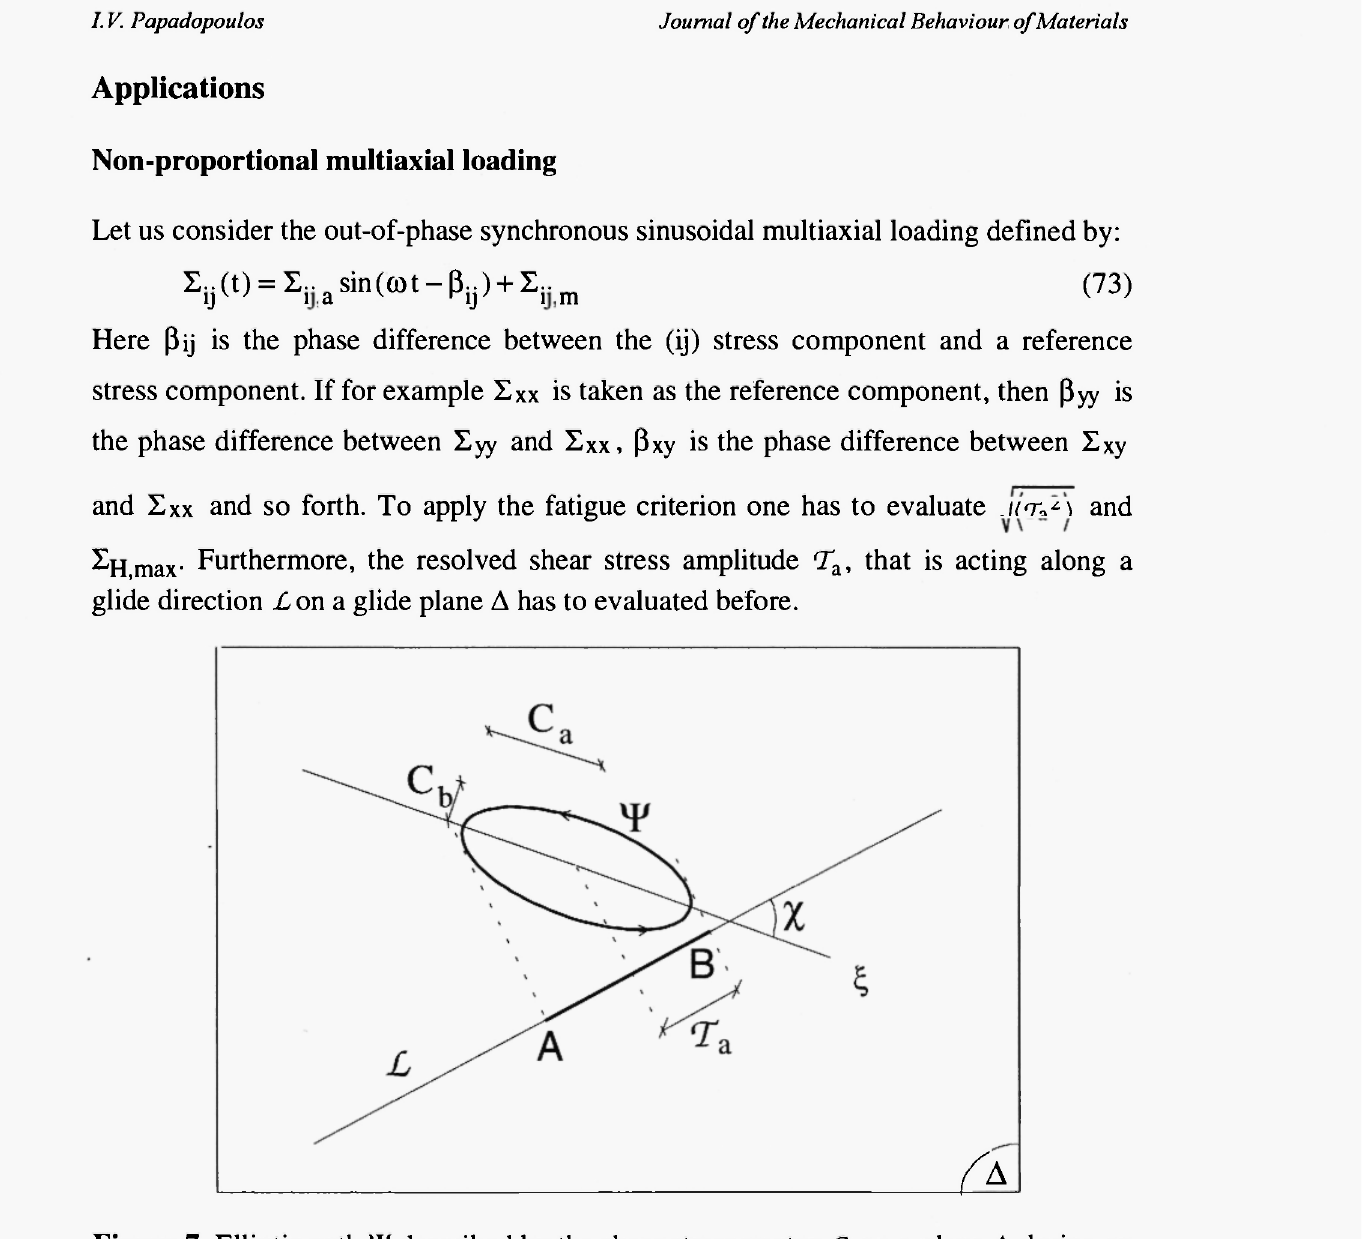
Figure 7. Elliptic path Ψ described by the shear stress vector C on a plane Δ during an out-of-phase synchronous sinusoidal